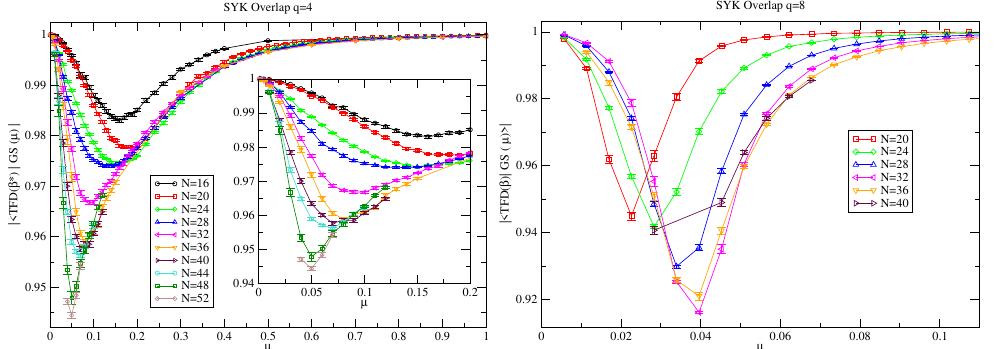
Figure 1 . Average overlap O = |h TFD( β ) | GS( µ ) i| at the optimal temperature, β = β ∗ ( µ ) , for the q = 4 (left panel) and q = 8 (right panel) coupled SYK models, as a function of coupling strength µ , for different system sizes N . Each data point is obtained as an average over at least 50 realizations of disorder. The inset in the left panel zooms on the region where the overlap is